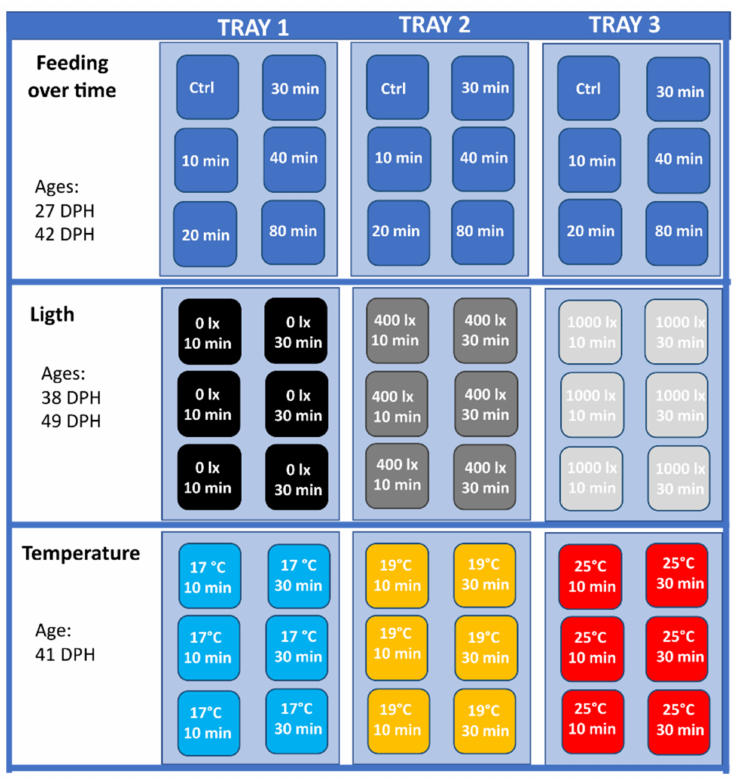
Figure 1. Experimental set-up for the different conditions tested with Sparus aurata